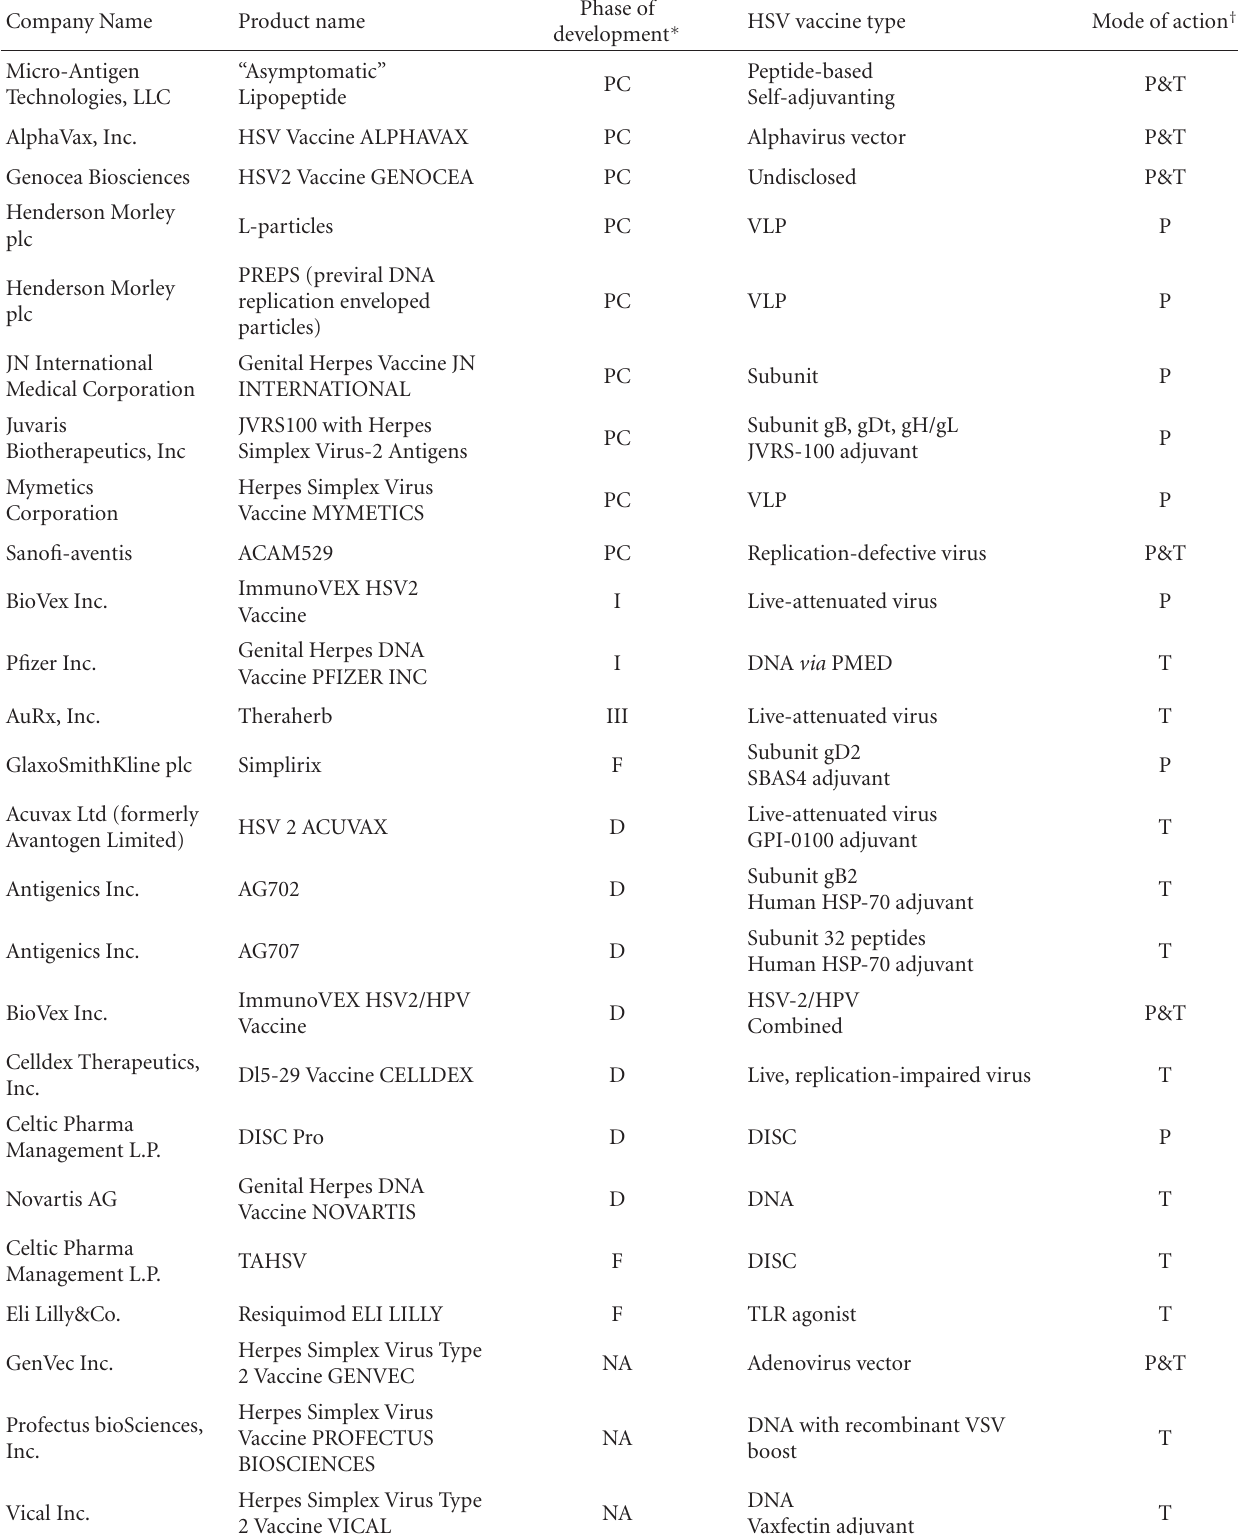
Table 1: A sampling of past and ongoing preclinical and clinical vaccine